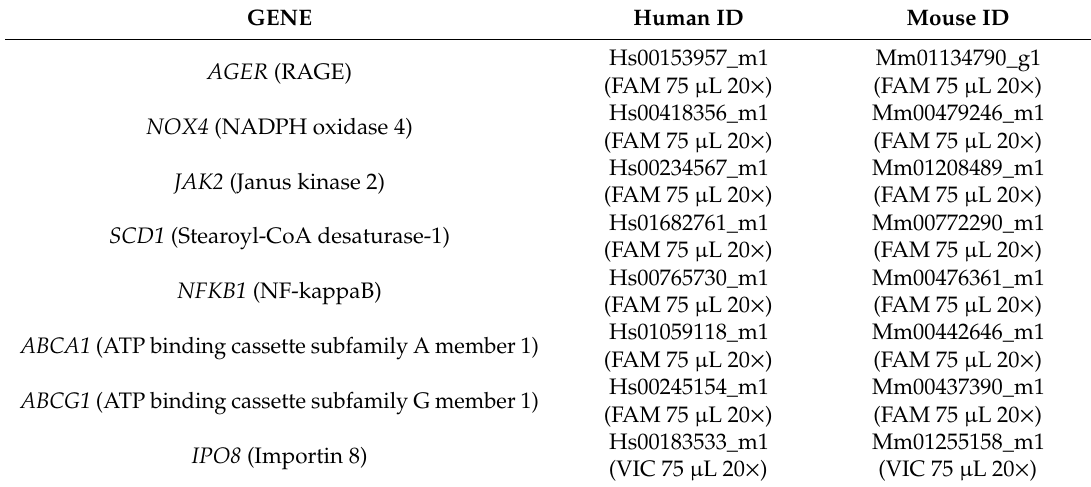
Table 2. Primers utilized-TaqMan Gene Expression Assays (Step One Plus Real Time